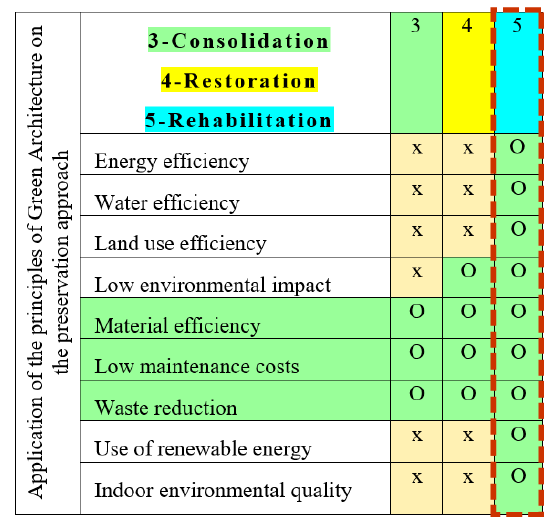
Table 2. Application of the principles of Green Architecture on the preservation approach: Consolidation, Restoration and Rehabilitation.